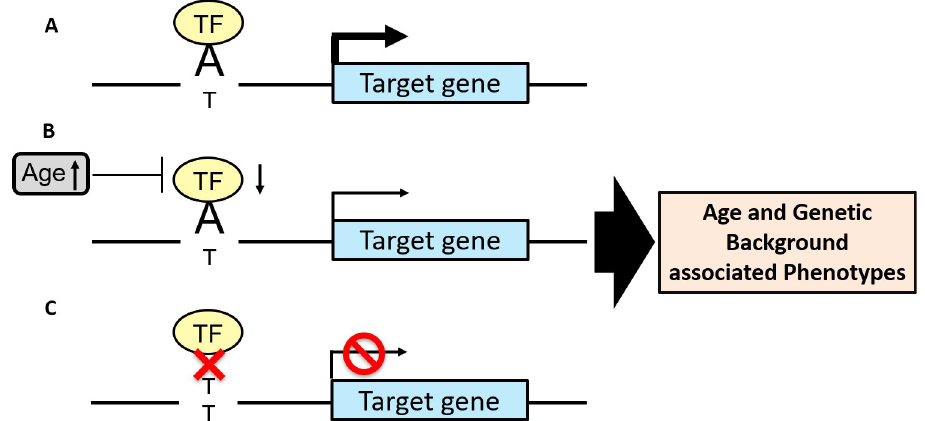
Fig 1. Hypothesized mechanism of SNP-Age interactions. (A) A TF binds to allele A to regulate the target gene. (B) With aging, the TF expression decreases and consequently so does the target gene’s expression for ‘A’ allele but has no effect on the ‘T’ allele (C)